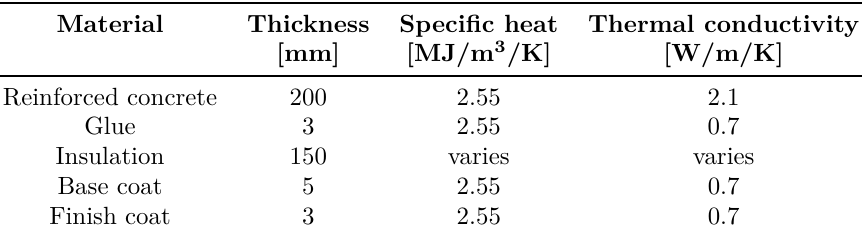
Table 2. Wall composition materials and their properties.